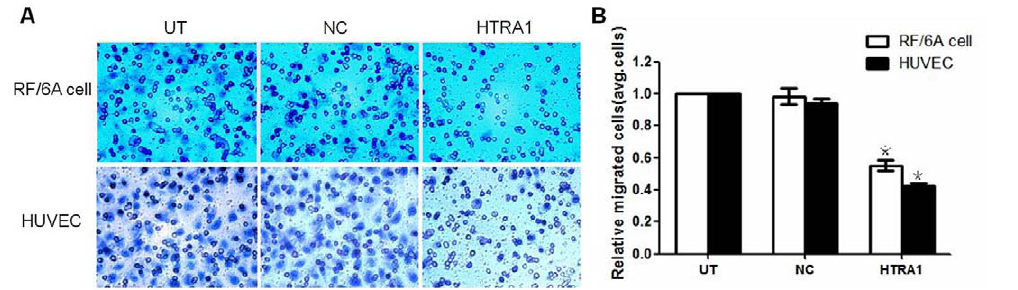
Figure 5. Effect of HTRA1 on the migration of RF/6A cells and HUVECs. The migratory activities of both cell lines were estimated based on the numbers of cells that had migrated through the filter of the chamber. The numbers of migrating cells in the HTRA1-transfected group were less than the number observed in the untransfected control group and the lentiviral vector control group (G, *p , 0.01).